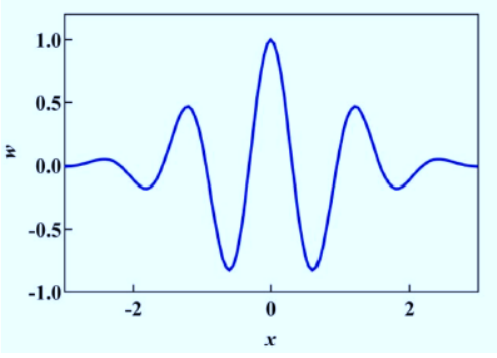
Figure 5. Mother wavelet.